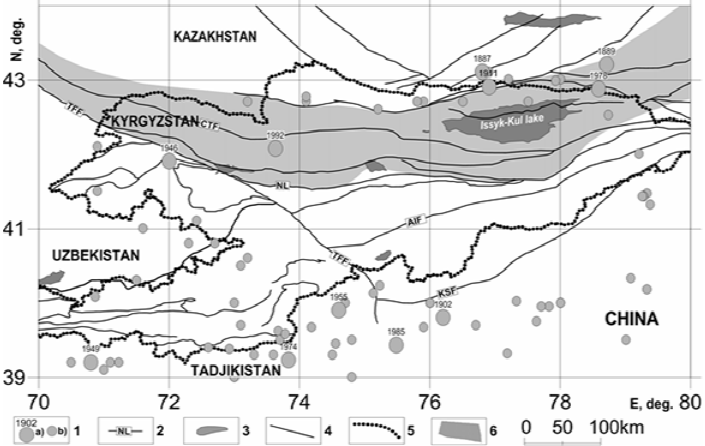
Fig. 2. Distribution of major seismic events in the Central Tien Shan: 1 - a) seismic events with M>7, b) seismic events with M>6; 2 - largest fault structures: TFF - Talas-Fergana fault, CTF - Central Terskei fault, NL - Nikolaev Line, AIF - Atbashi-Inylchek fault, KSF - Kokshaal fault; 3 - lakes and reservoirs; 4 - tectonic disturbances; 5 - border of the Kyrgyz Republic; 6 - Issyk-Kul microcontinent